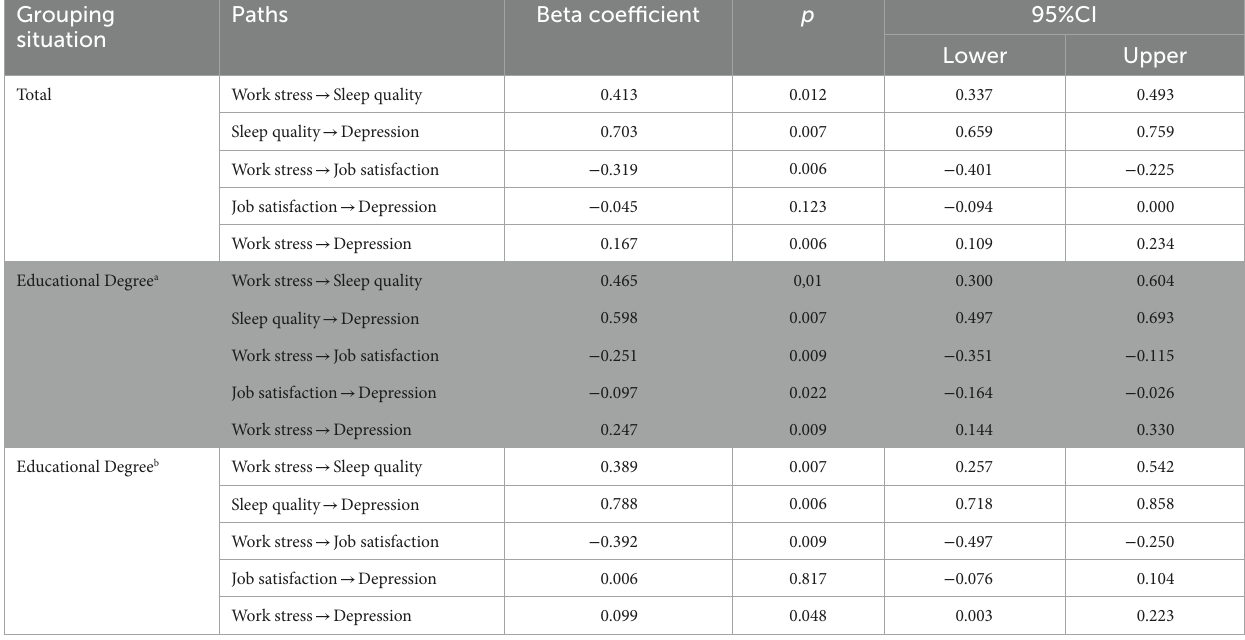
TABLE 3 Standardized effects and 95%